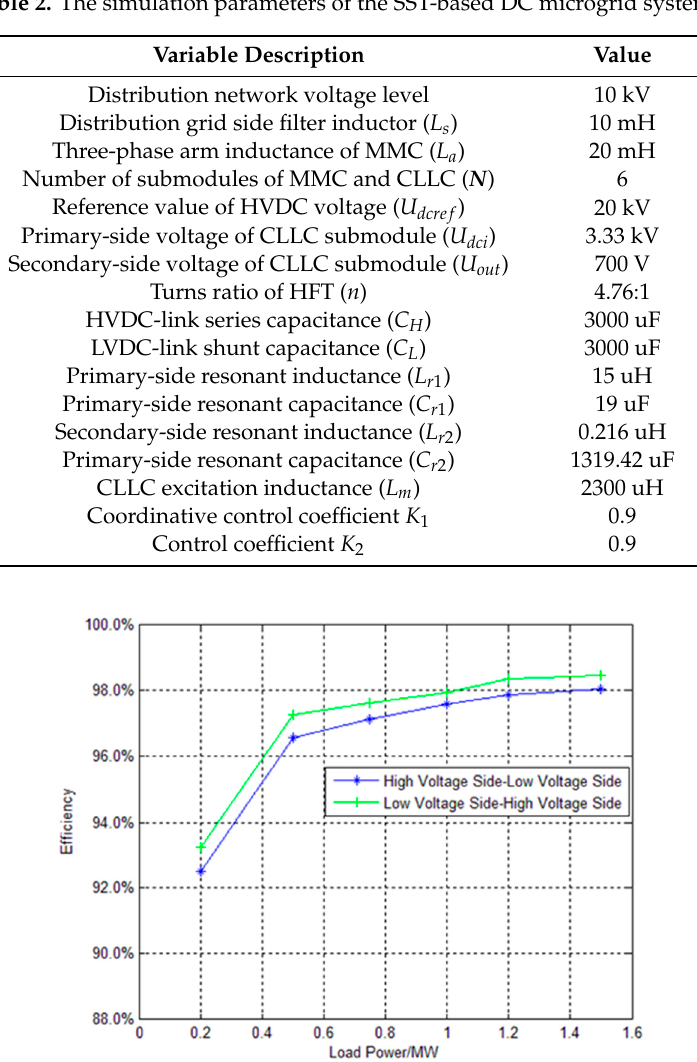
( b ) Figure 13. The comparison of voltage response under continuous power fluctuation: ( a ) the LVDC bus voltage response; ( b ) the HVDC bus voltage response.